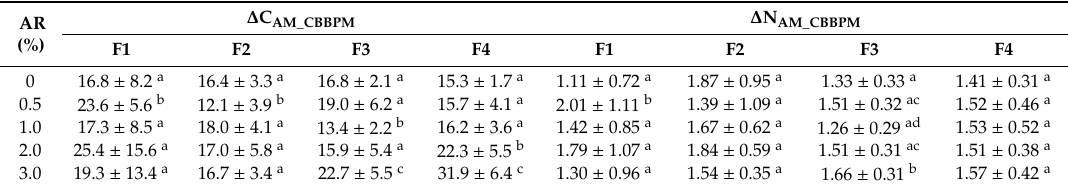
Table 7. Changes in soil carbon and nitrogen content for test fields following soil amelioration compared to original (untreated) soil (t(C)ha − 1 season − 1